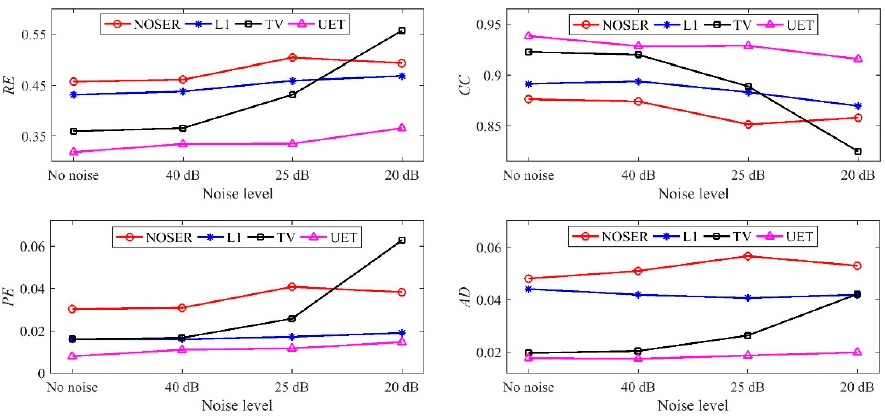
Figure 9. Mean value of the quantitative indexes.